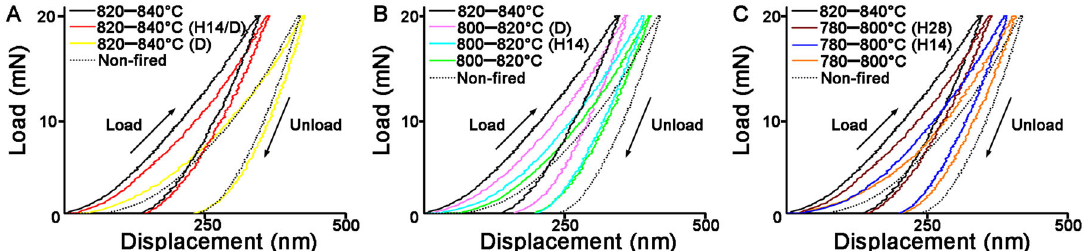
Fig. 1 Load – displacement curves of LDGC materials heated under various thermal conditions. Non- fi red and 820 – 840 °C groups were set as reference in each group to estimate the mechanical properties of LDGC materials that were treated at various temperature levels.